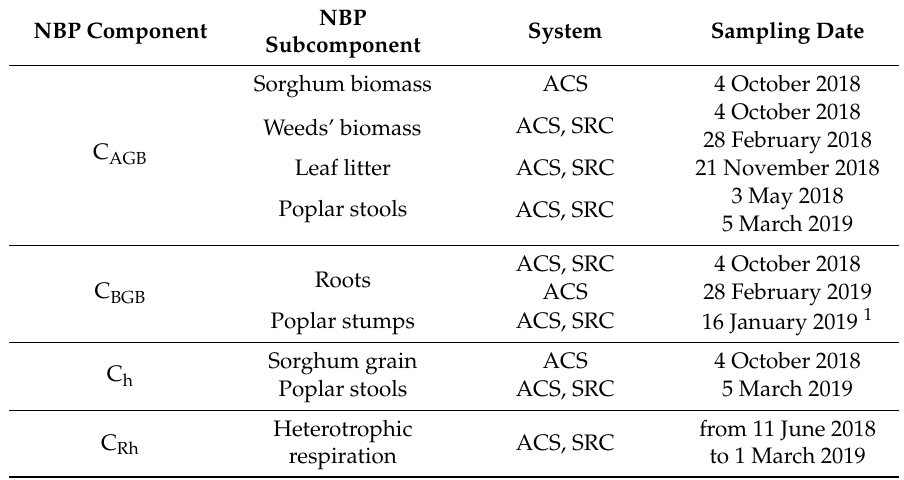
Table 3. Description of the NBP (Net Biome Production) components with their sampling dates for the two systems, the Alley Cropping System (ACS) and poplar Short Rotation Coppice system